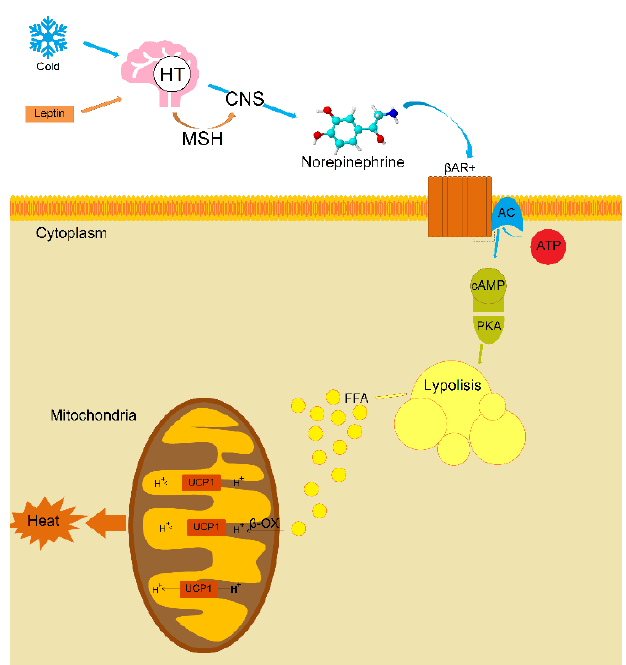
Figure 4. Possible mechanism of leptin-dependent neuro-fatty linkage of nonshivering thermogenesis in brown adipose tissue (The figure adapted from the articles: [64,65,67]). Note: